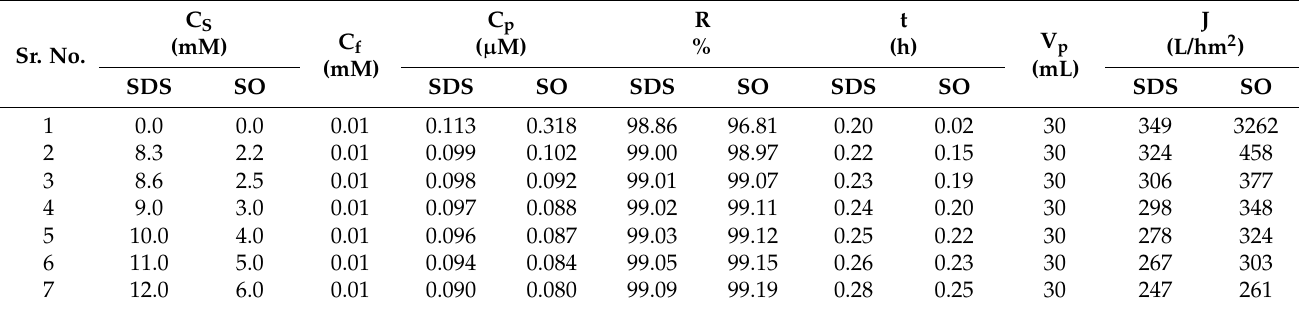
Table 2. Calculation of rejection coefficient (R%) and permeate flux (J) of Co 2+ against different surfactant concentrations (Cs) at fixed Co 2+ concentration in feed (C f ), Co 2+ concentration in permeate solution (C p ), time of filtration (t), and permeate volume (V p ).